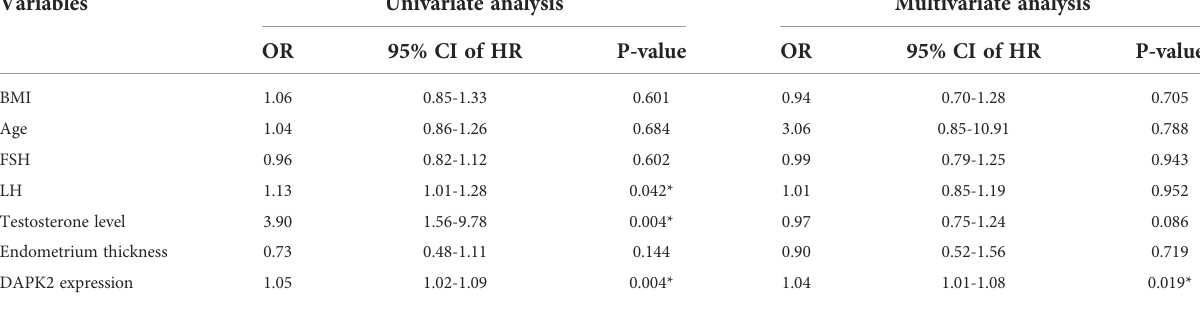
TABLE 4 Univariate and multivariate logistic regression of the clinical data and DAPK2. Variables